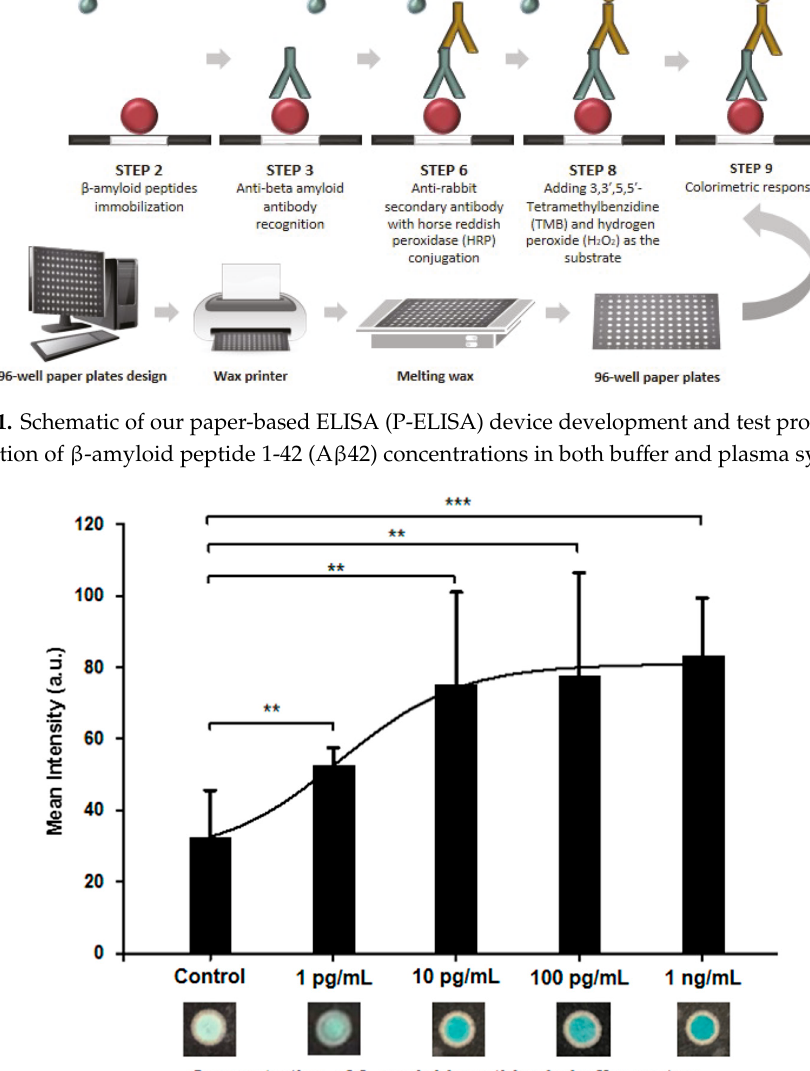
Scheme 1. Schematic of our paper-based ELISA (P-ELISA) device development and test procedure for the detection of β -amyloid peptide 1-42 (A β 42) concentrations in both buffer and plasma systems.